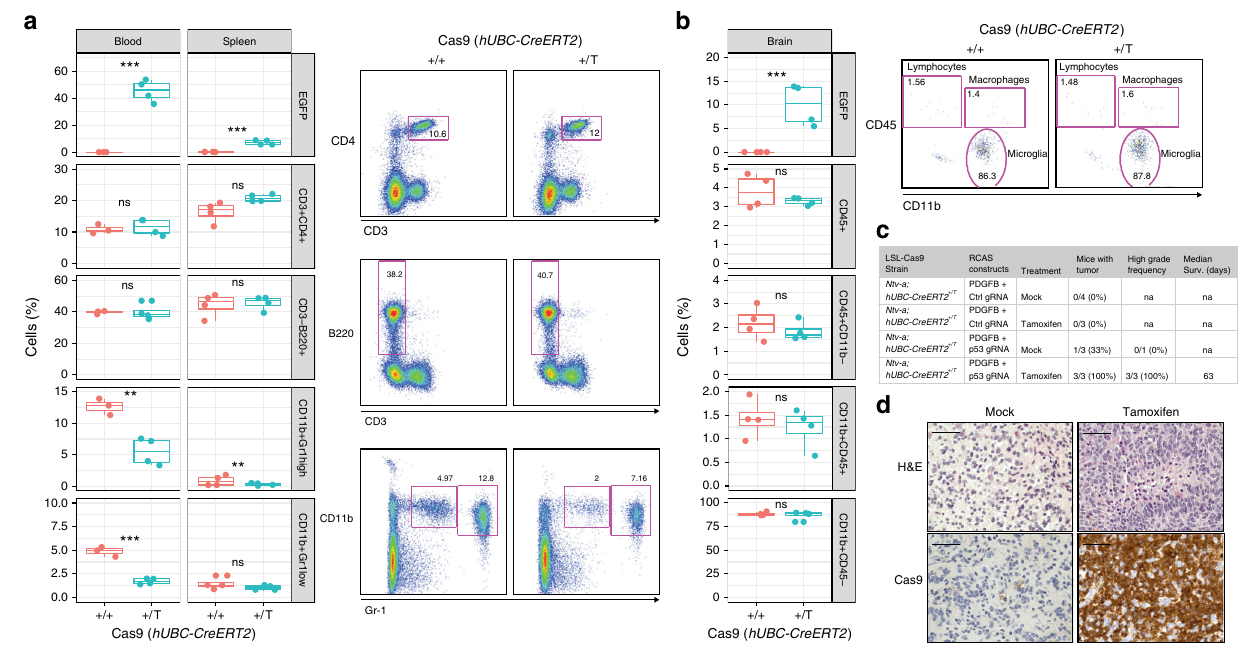
Fig. 3 Ubiquitous Cas9 expression in TVA-Cas9 adult mice does not induce a robust immune response. a Left panels: Flow cytometry analysis for the speci fi ed markers in blood and spleen of Ntv-a; LSL-Cas9 ; hUBC-CreERT2 mice of the indicated genotype. Four-week-old mice were treated with tamoxifen in the food for 5 consecutive weeks. Right panels: representative fl ow cytometry plots, with the gating strategy used for the analysis. Student ’ s t test: *** P < 0.001, ** P < 0.005, * P < 0.05. The upper and lower hinges correspond to the fi rst and third quartiles (the 25th and 75th percentiles). The upper whisker extends from the hinge to the highest value that is within 1.5 × IQR of the hinge, where IQR is the inter-quartile range. The lower whisker extends from the hinge to the lowest value within 1.5 × IQR of the hinge. b Left panels: Flow cytometry analysis for lymphocytes, macrophages and microglia of the brain of the mice in a . Right panels: representative fl ow cytometry plots, with the gating strategy used for the analysis. c Table summarizing the injections performed in the Ntv-a; LSL-Cas9 ; hUBC-CreERT2 adult mice. Mice injected with RCAS-PDGFB + RCAS-Trp53-gRNA and treated with tamoxifen to induce Cas9 expression, develop high-grade gliomas. d H&E and Cas9 IHCs of RCAS-PDGFB + RCAS-Trp53-gRNA tumors for the indicated treatment. High-grade glioma features and Cas9 expression are present only in the tamoxifen-treated mice. Scale bars: H&E 100 μ m; IHCs 50 μ